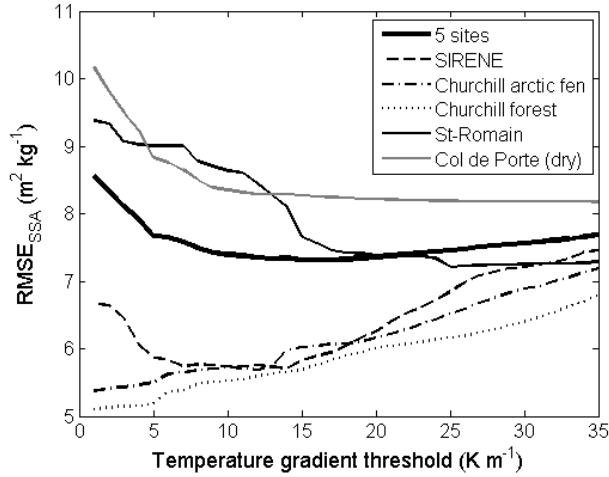
Fig. 5. RMSE SSA between the measured SSA and the simulated SSA using CLASS-SSA as a function of the temperature gradient threshold (TG treshold